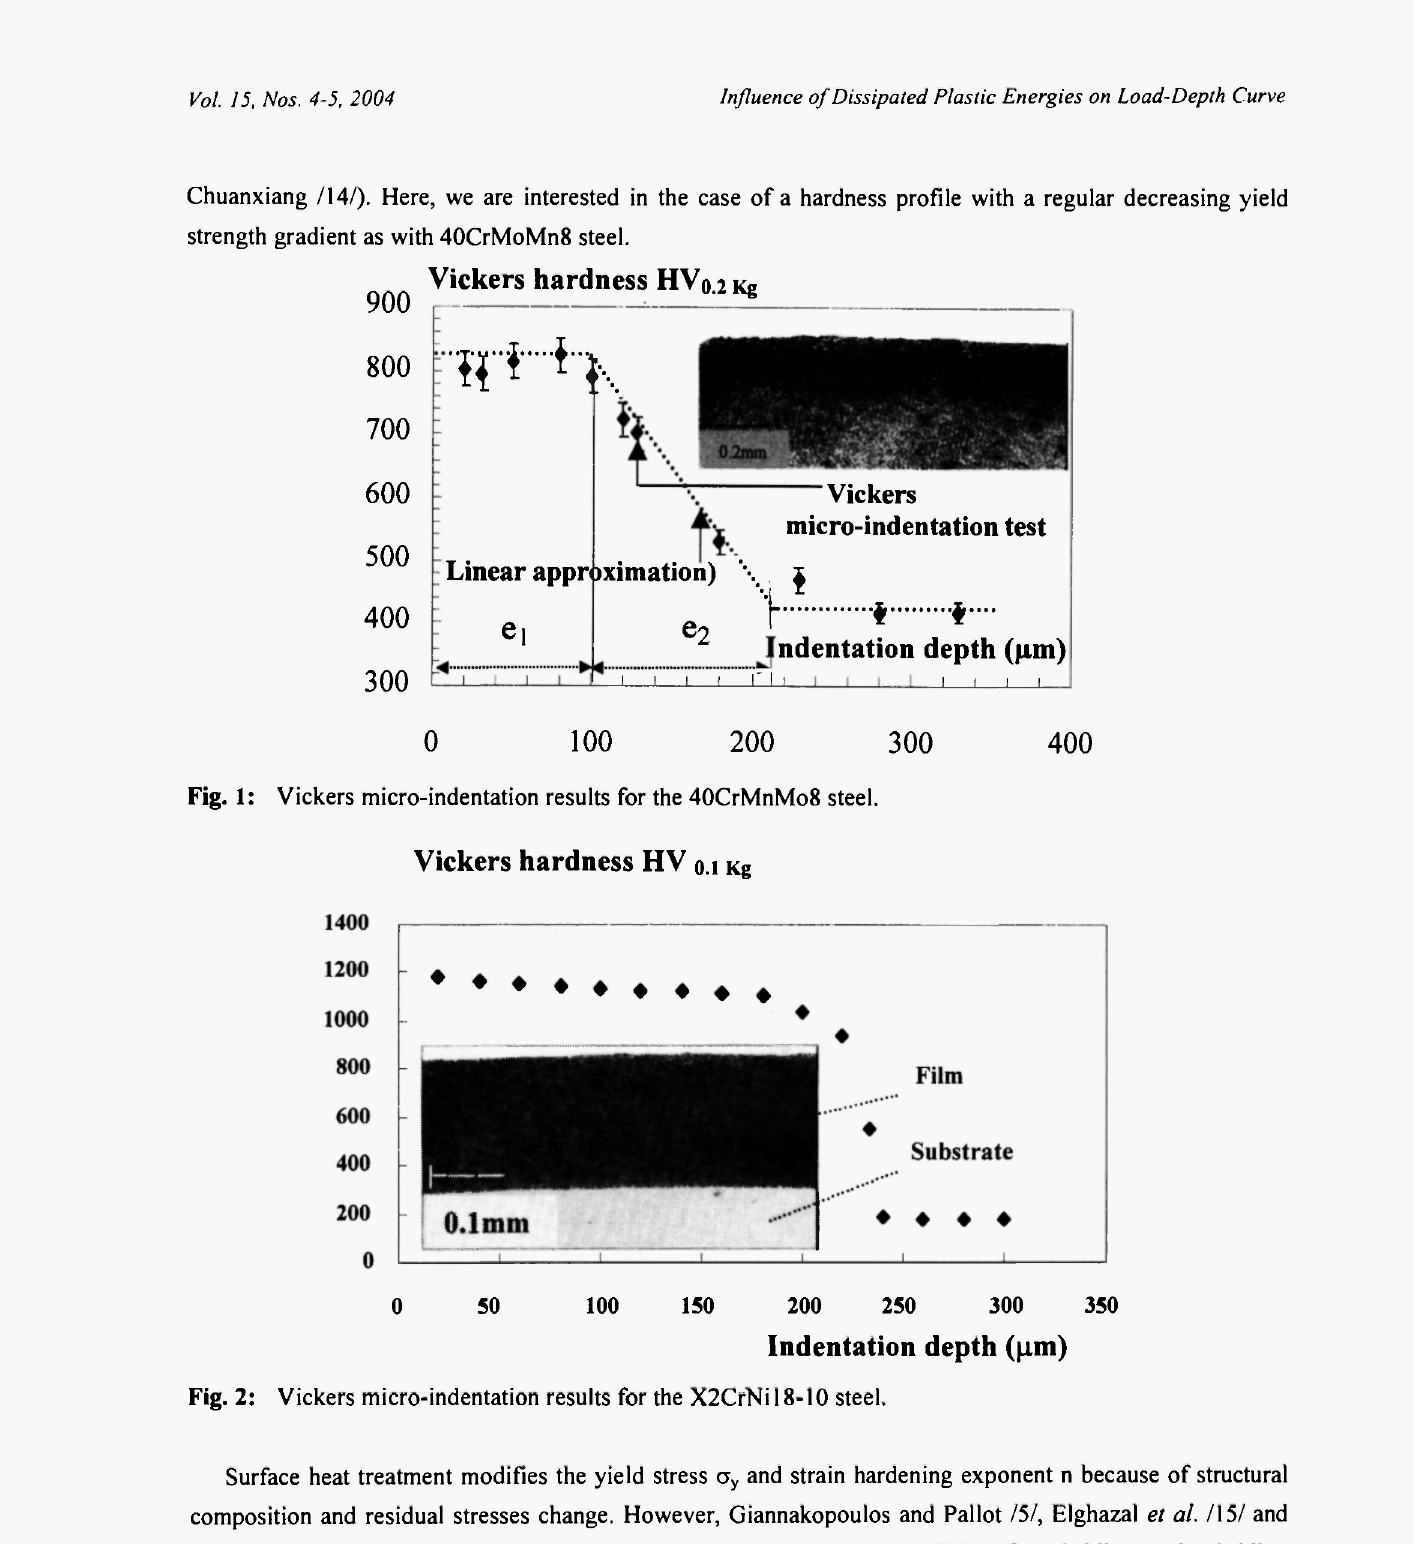
Fig. 2: Vickers micro-indentation results for the X2CrNil8-10